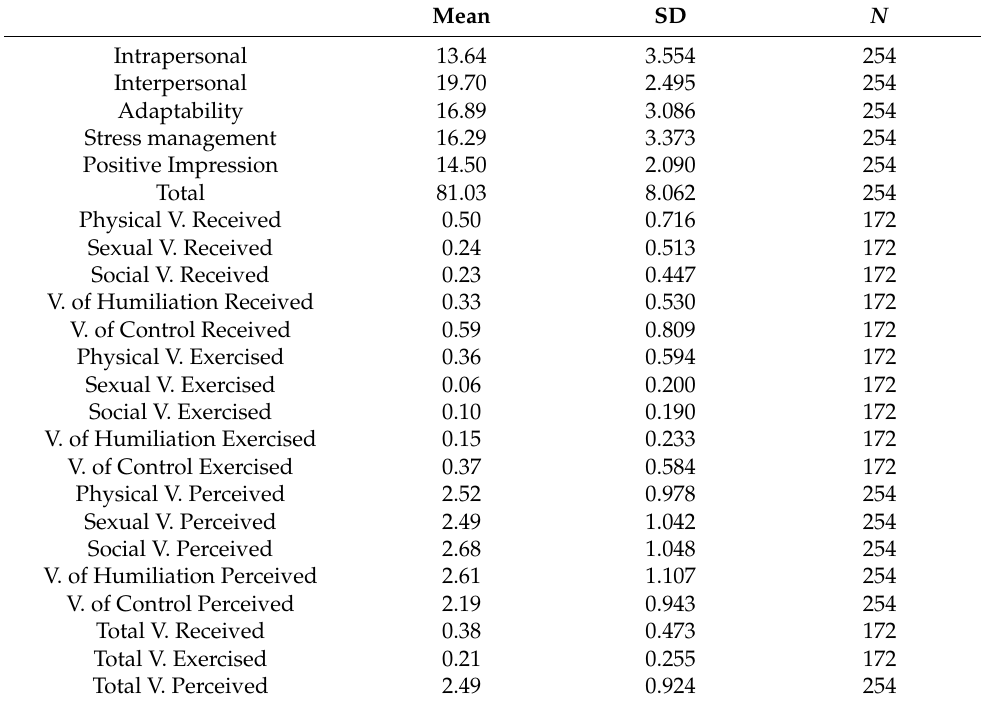
Table 1. Descriptive analysis of Emotional Intelligence and types of violence.